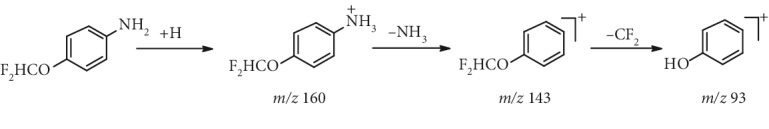
Chemical structures of PPZS, DMBZ, and potential genotoxic impurities.